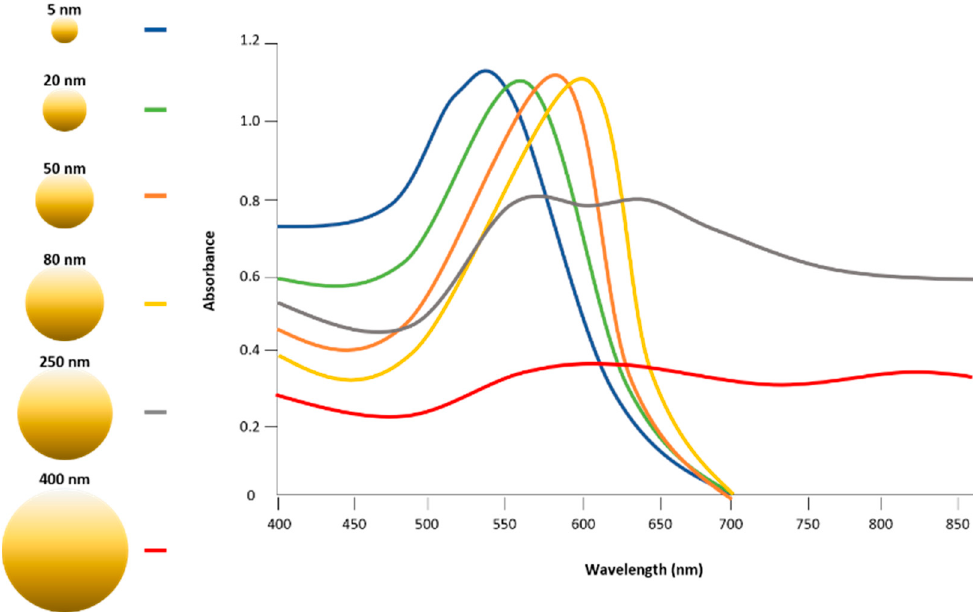
Figure 3. Absorption spectra of UV-visible spectrometry, depending on the diameter of gold nanoparticles, 5 to 400 nm, demonstrating a transition of specific wavelengths that generate surface plasmon resonance.